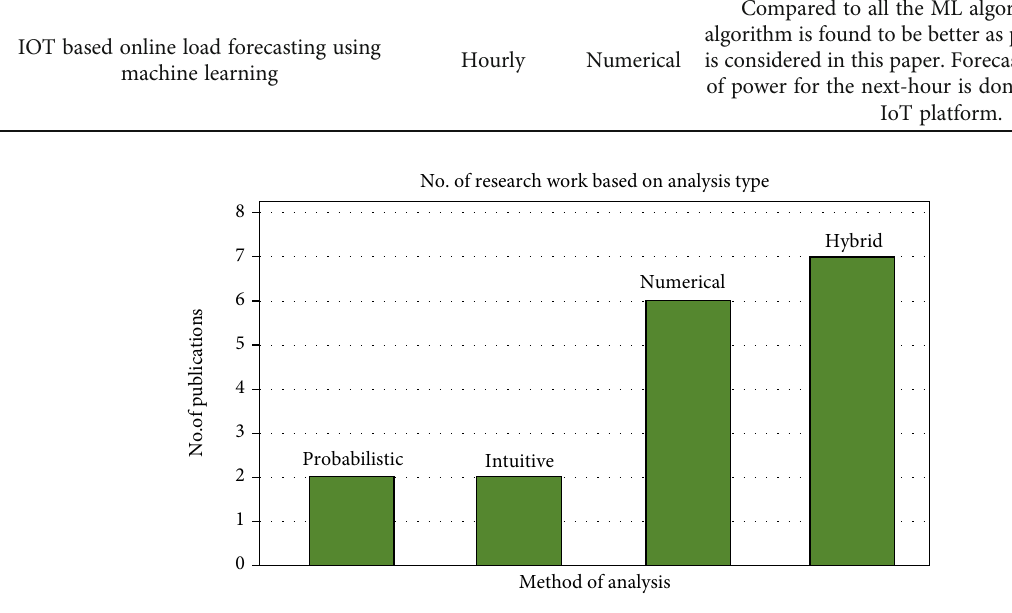
Figure 14: Number of research work based on method of analysis.